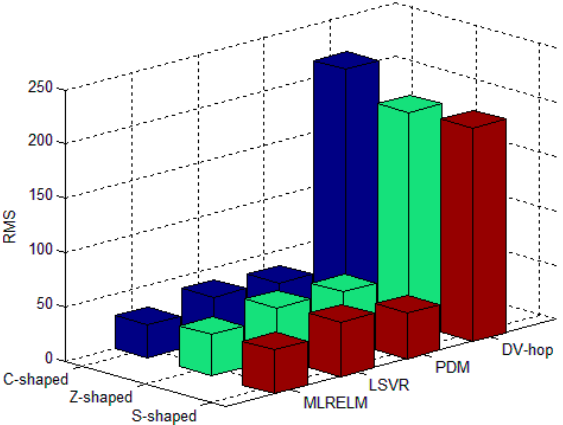
Figure 11. Average RMS for different algorithms in the random deployment environment.